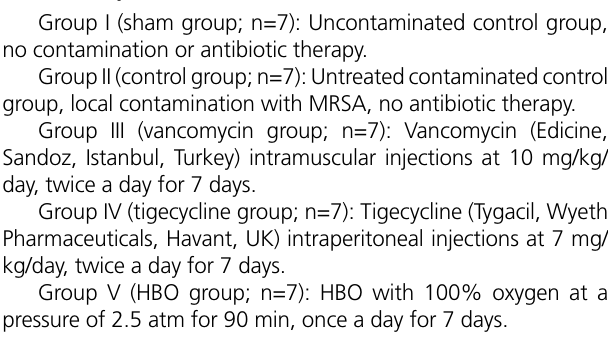
540 Brazilian Journal of Cardiovascular Surgery